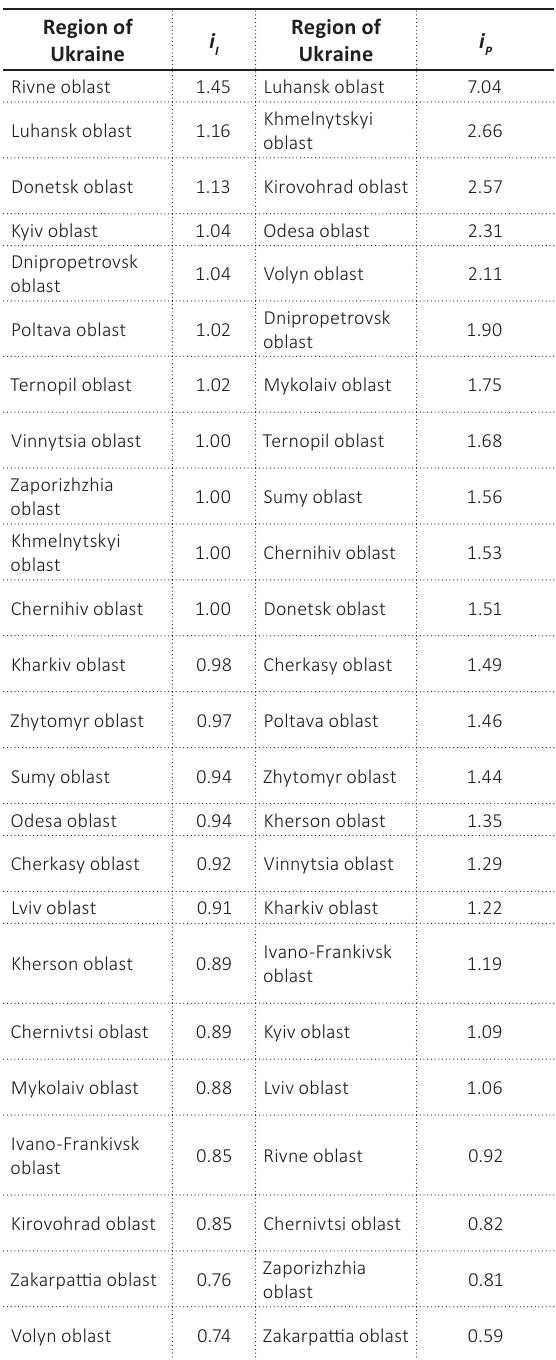
Table 7. Results of calculating dynamic indices i and i by regions of Ukraine, P